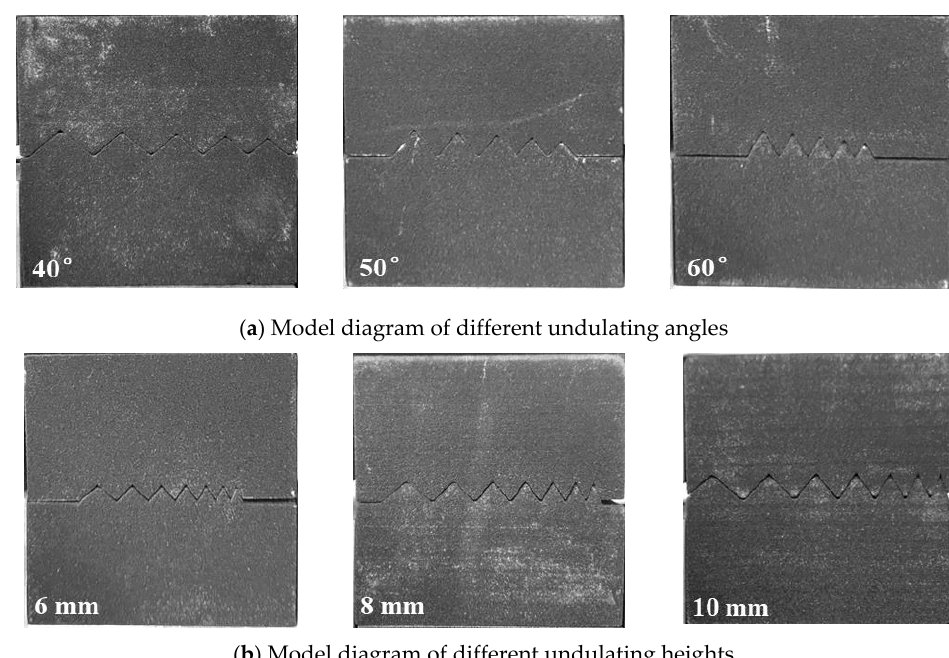
Figure 3. Model diagram of different undulating angles and height.